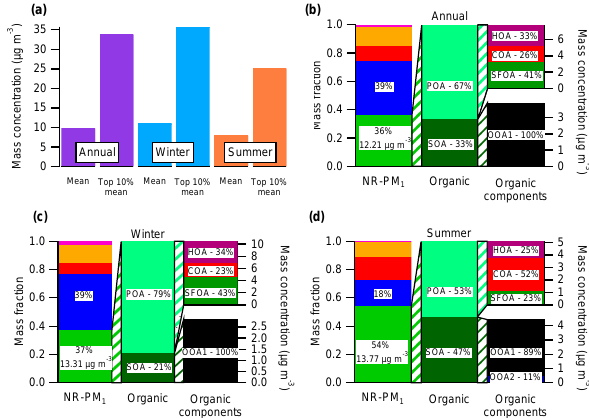
Figure 8. (a) Mean concentrations of the full calendar year (2012– 2013), winter, and summer months. The average concentration of the top 10th percentile for the year as well as the top 10th percentile in the winter and summer are also shown. (b) Average fractional contributions of all species to the top 10th percentile for the year, with an expansion of the organic fraction into each of its primary and secondary components. (c) Average fractional contributions of all species to the top 10th percentile in the winter, with an expansion of the organic fraction into each of its primary and secondary com- ponents. (d) Average fractional contributions of all species to the top 10th percentile in the summer, with an expansion of the organic fraction into each of its primary and secondary components. In all figures, SFOA and OOA2 refer to SFOA mod and OOA2 mod respec- tively. Note that the PMF data (middle and right bars) do not include the summer period as detailed in Sect. 4.1 as well as Sects. 4.1 and 4.2 in the